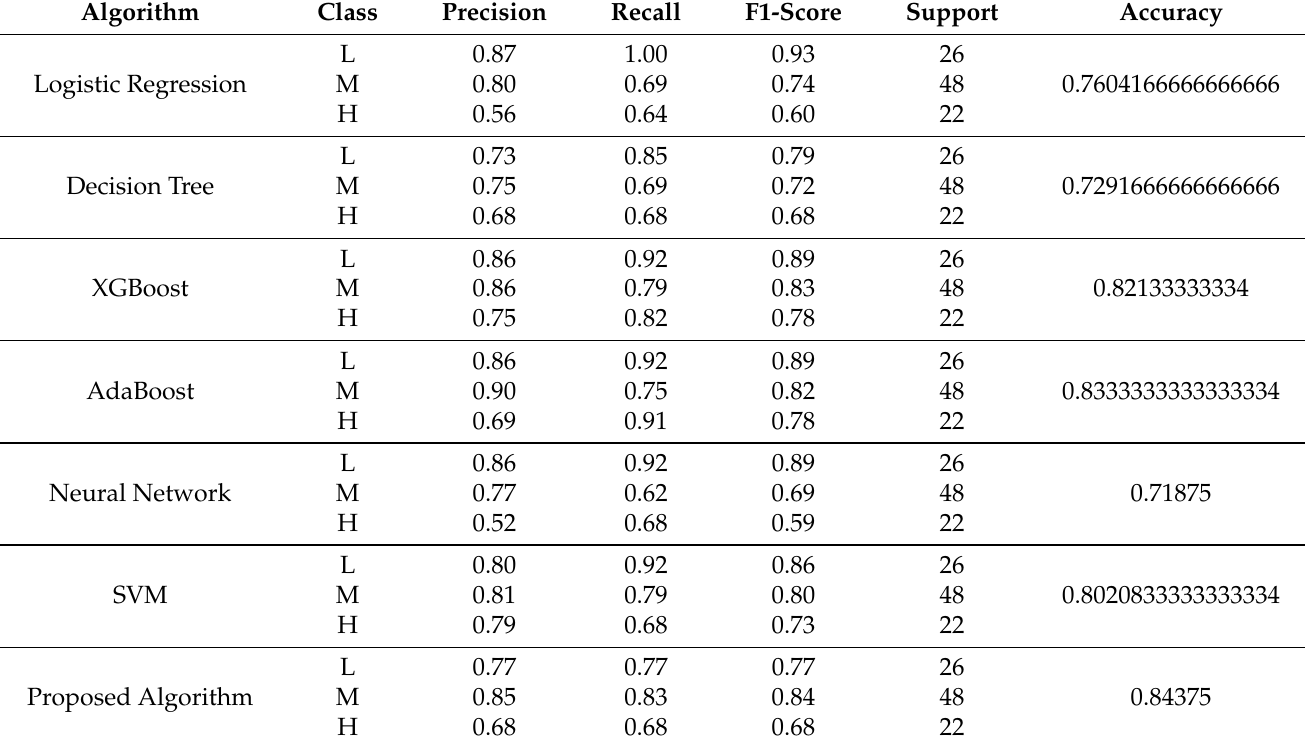
Table 3. Comparing results with all experimental algorithms on the xAPI-Edu-Data